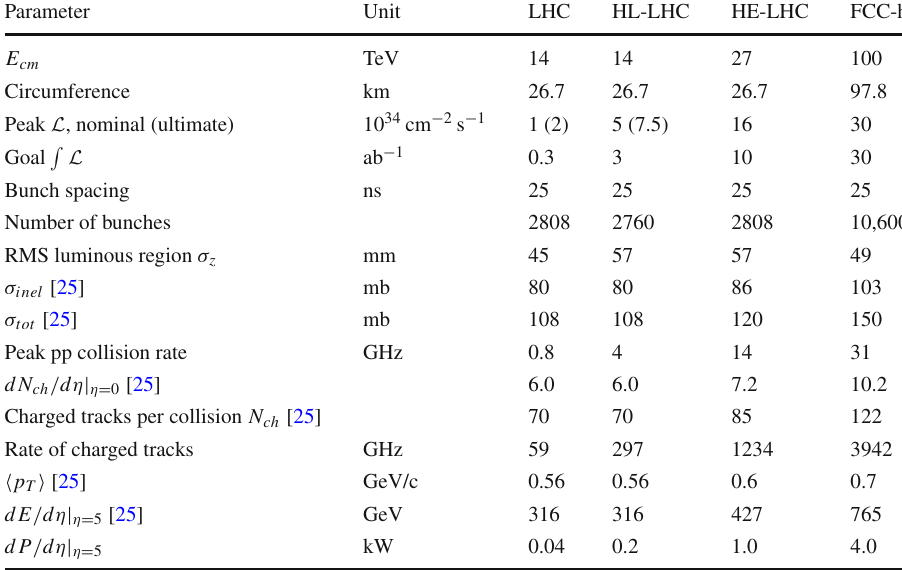
Table 2.2 Reference parameters for operations at (HL-)LHC, HE-LHC